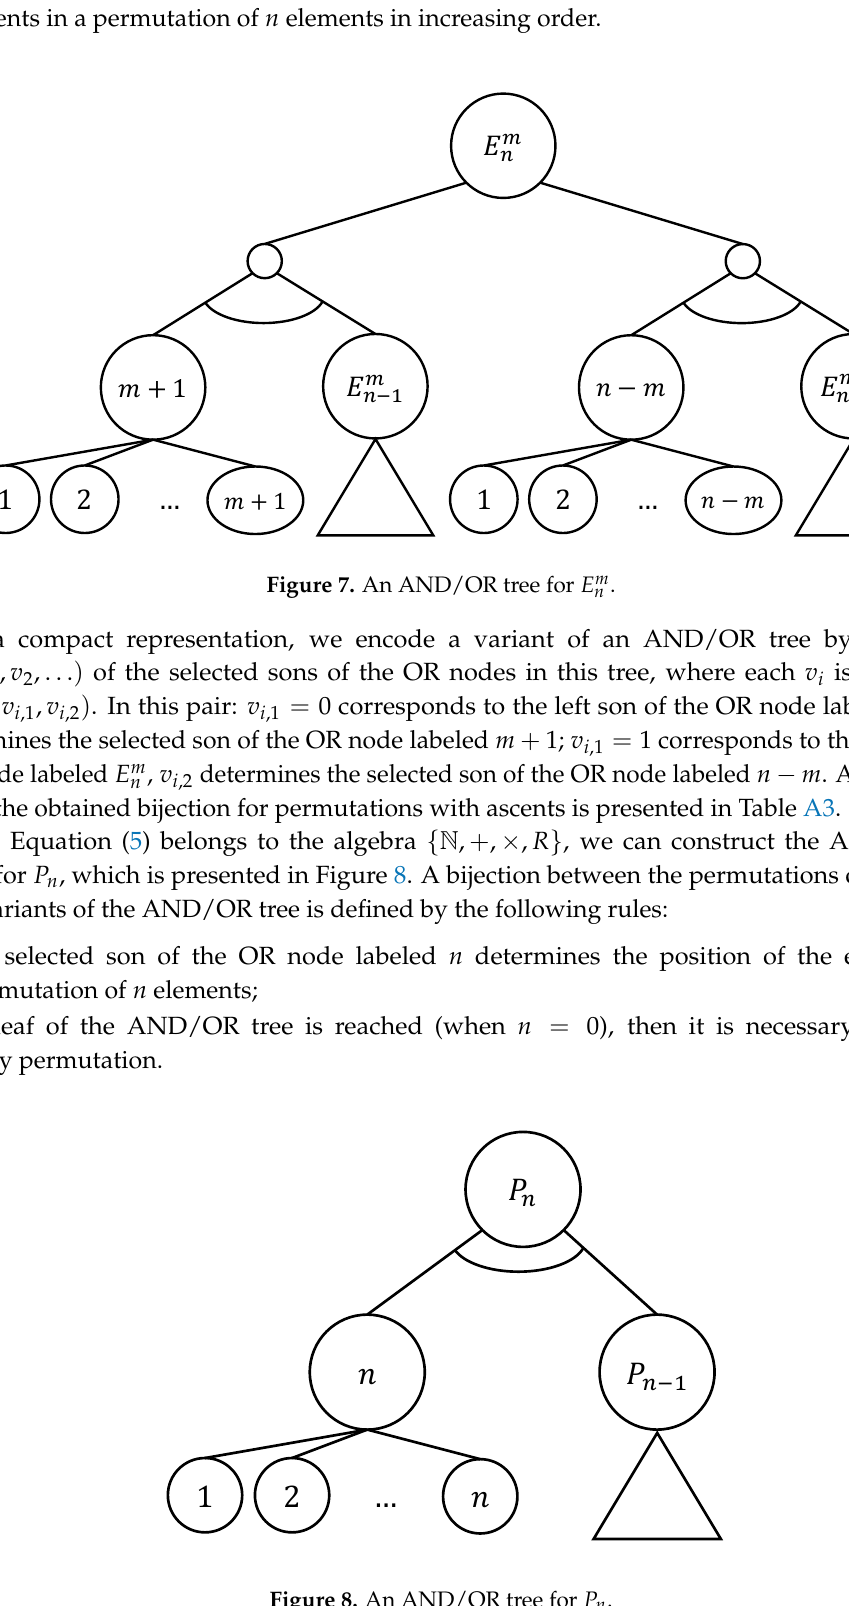
Figure 8. An AND/OR tree for P n